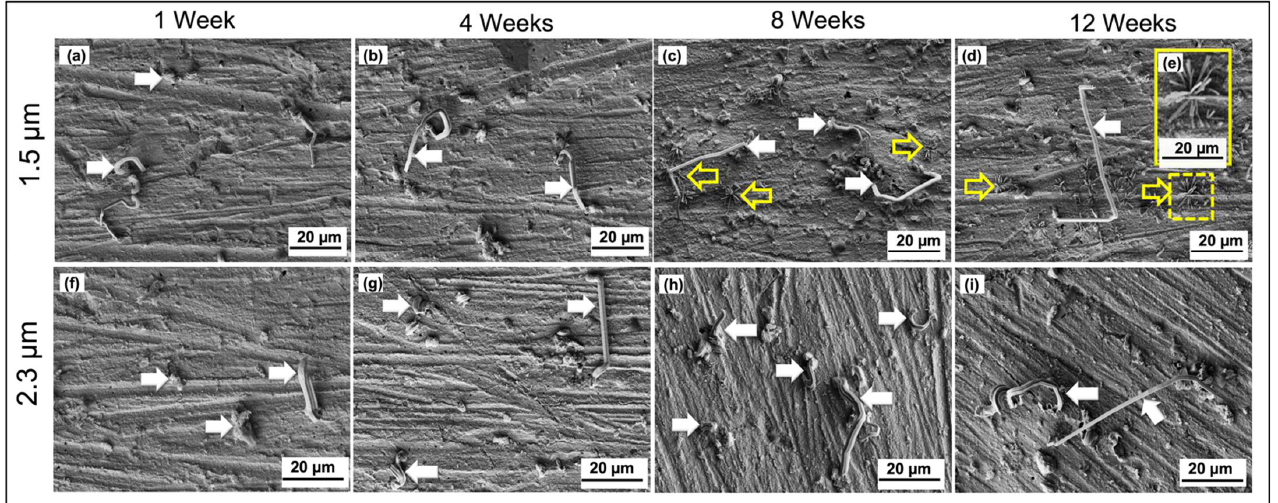
Figure 3. FESEM micrographs of tin whiskers (solid arrows) and CuO flowers (hollow arrows) observed on the non-indented surface of 1.5 µm ( a – e ) and 2.3 µm ( f – i ) coatings for 1–12 weeks of storage time. Image ( e ) is the high-magnification image of CuO flowers (hollow arrow) in the marked area in image ( d ).